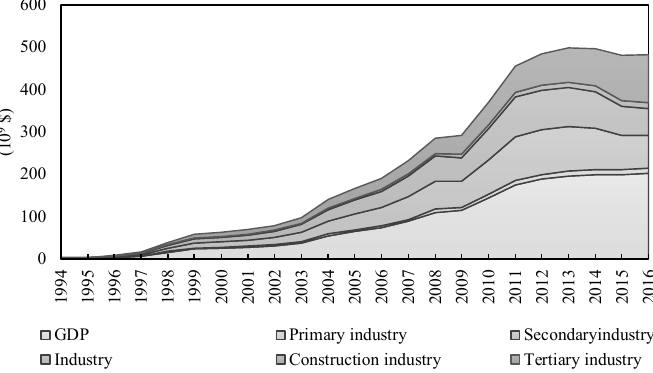
Figure 3. Power consumption of Shanxi, China (1999–2016).